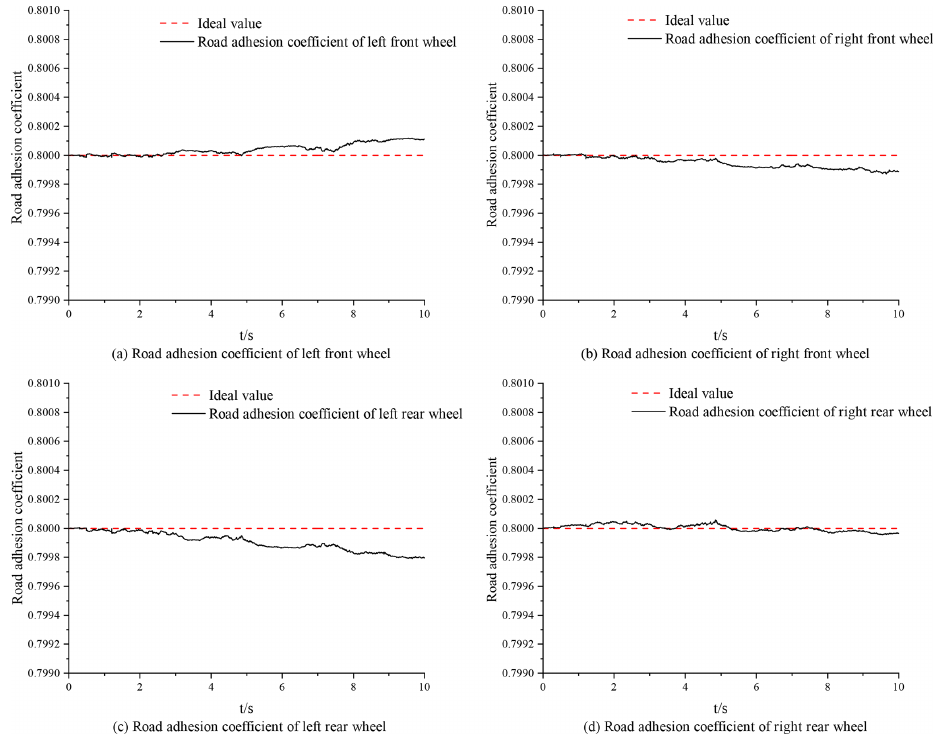
Figure 6. The high-adhesion road surface identification effect based on the PF algorithm.